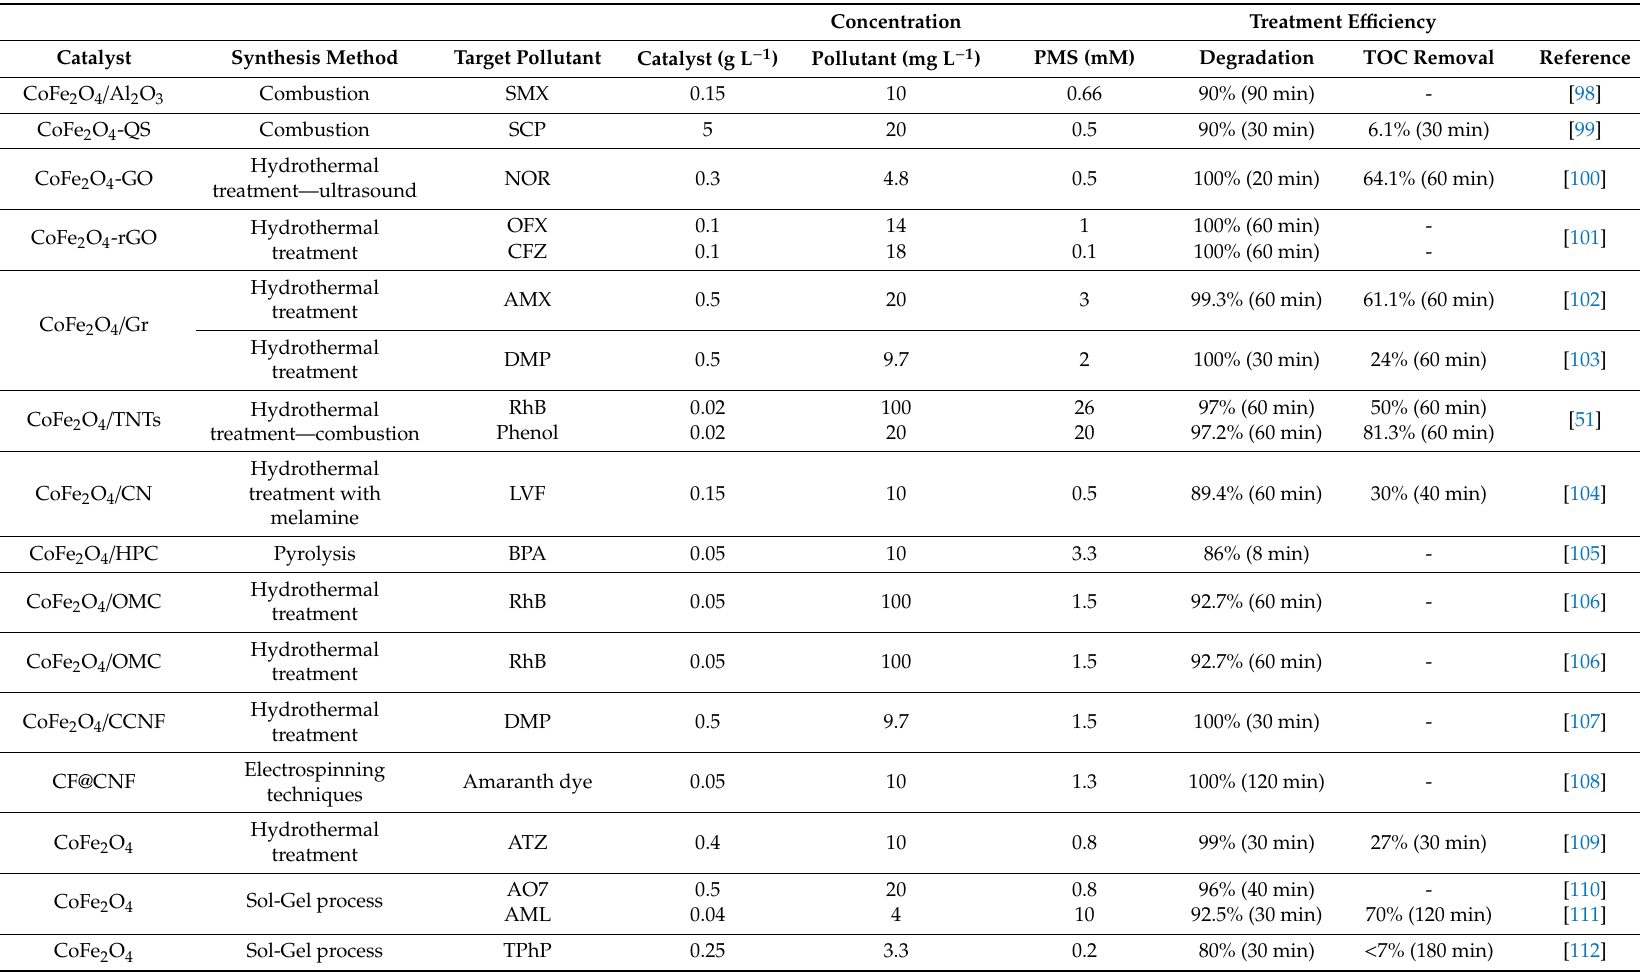
Table 4. Degradation of pollutants by the combination of peroxymonosulfate (PMS) and